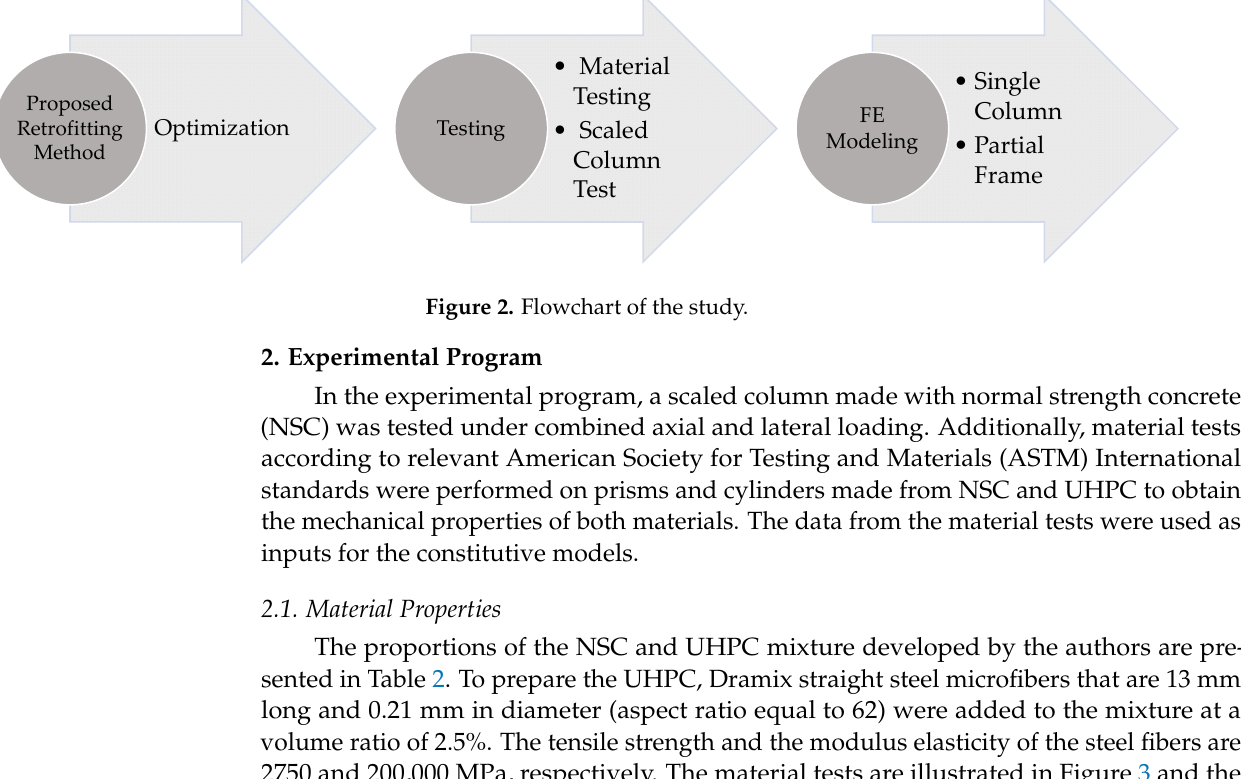
Table 2. Mixture proportioning of UHPC.